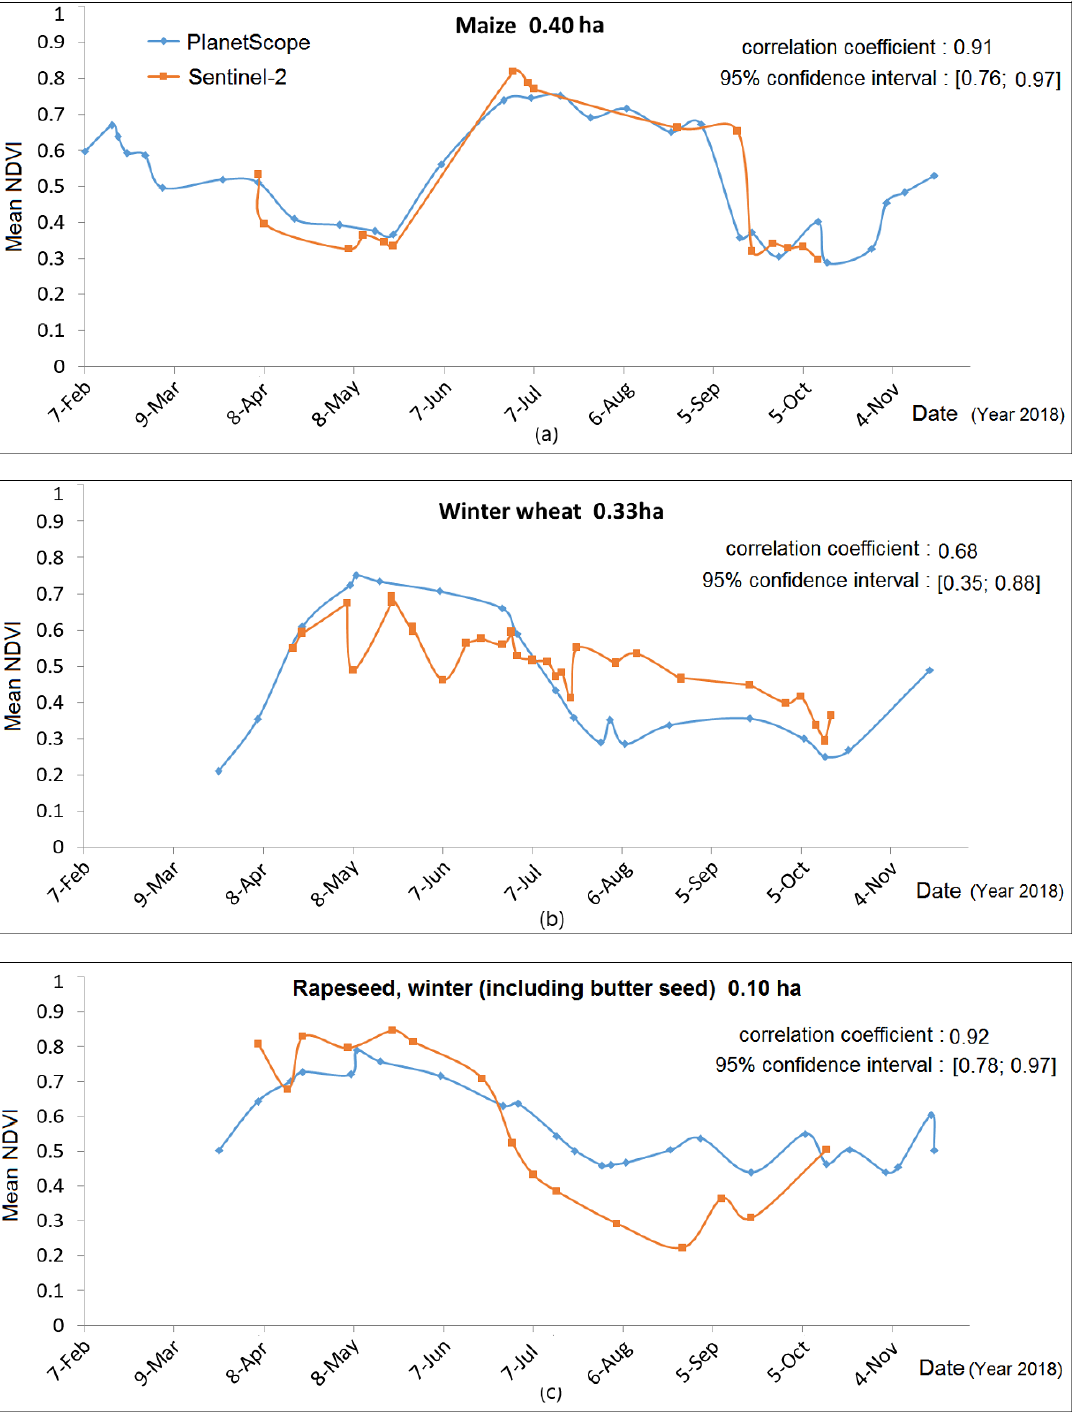
Figure 7. Typical examples of the visual assessment of NDVI time series pairs: ( a ) illustration of the agreement; ( b ) illustration of the disagreement; ( c ) illustration of the doubtful case.